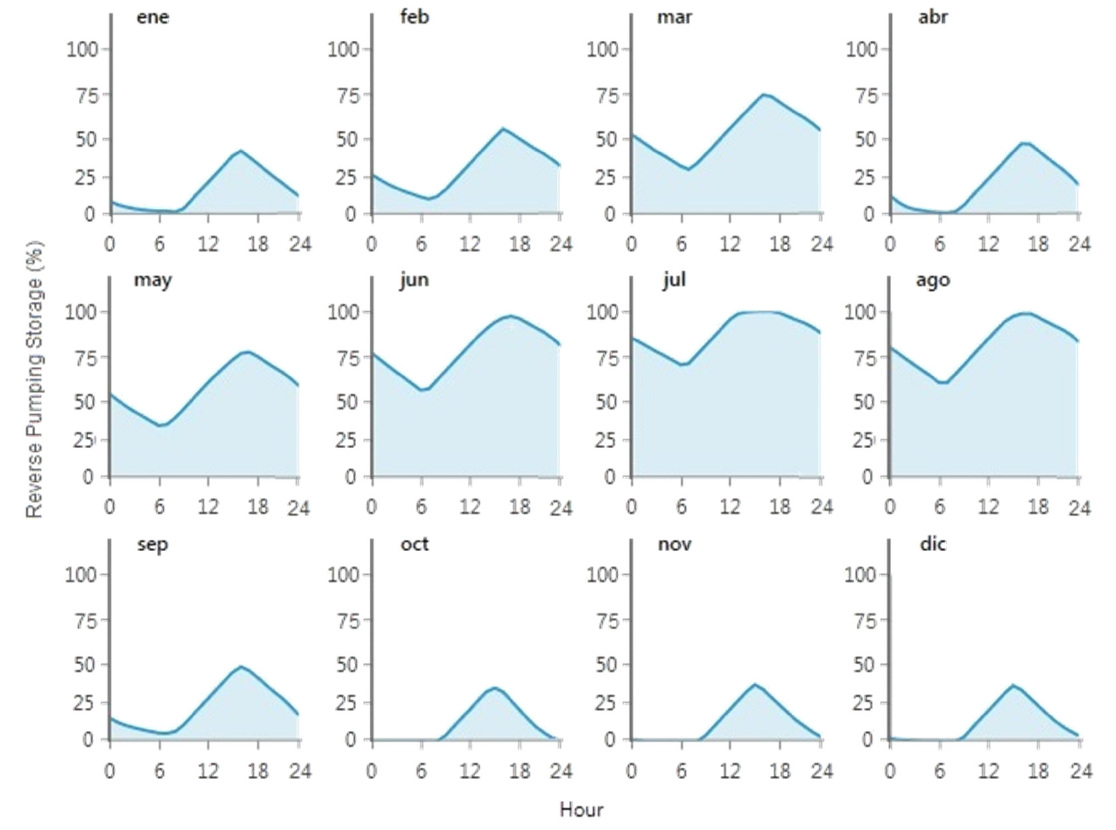
Figure 19. Hourly values of the monthly averaged storage capacity in the reversible pumping system for the Gran Canaria Island.